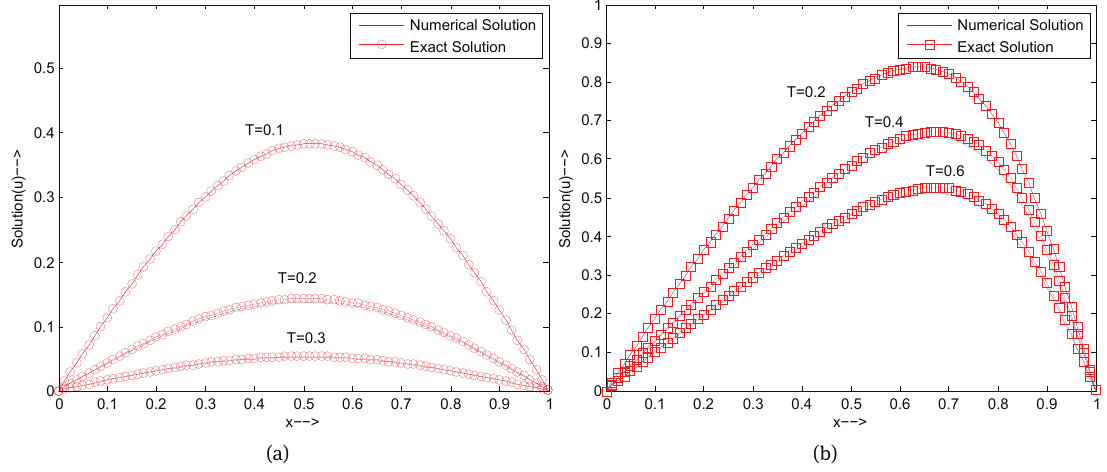
Fig. 5: Numerical solutions of Example 2 at different times for Δx = 0.0125 and different values of ν and Δt , (a) ν = 1 , Δt = 0.0001 (b) ν = 0.1 , Δt = 0.001 .